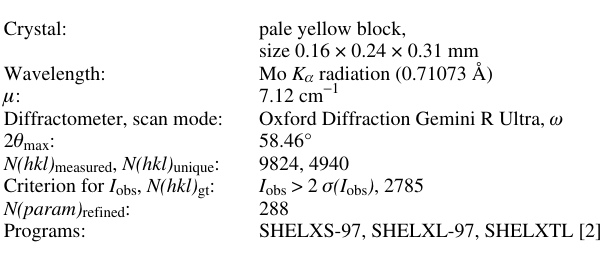
Table 1. Data collection and handling.